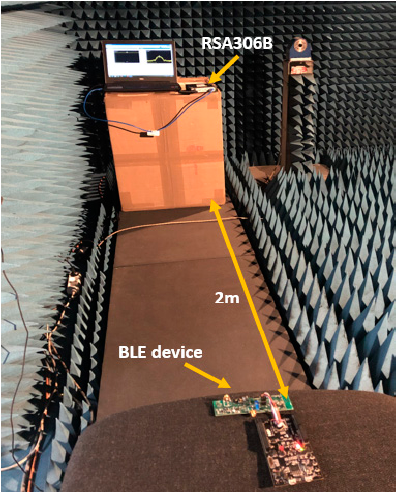
Figure 3. Experimental setup in the anechoic chamber. The BLE device emits the signal at 2 m from the RSA306B. The latter is equipped with a BLE antenna and driven by the Tektronix SignalVu-PC software. This way, we can capture the BLE signal in real time and record it as IQ samples on the PC in order to be used later in the script for estimating the power spectral density using Welch’s average periodogram method.